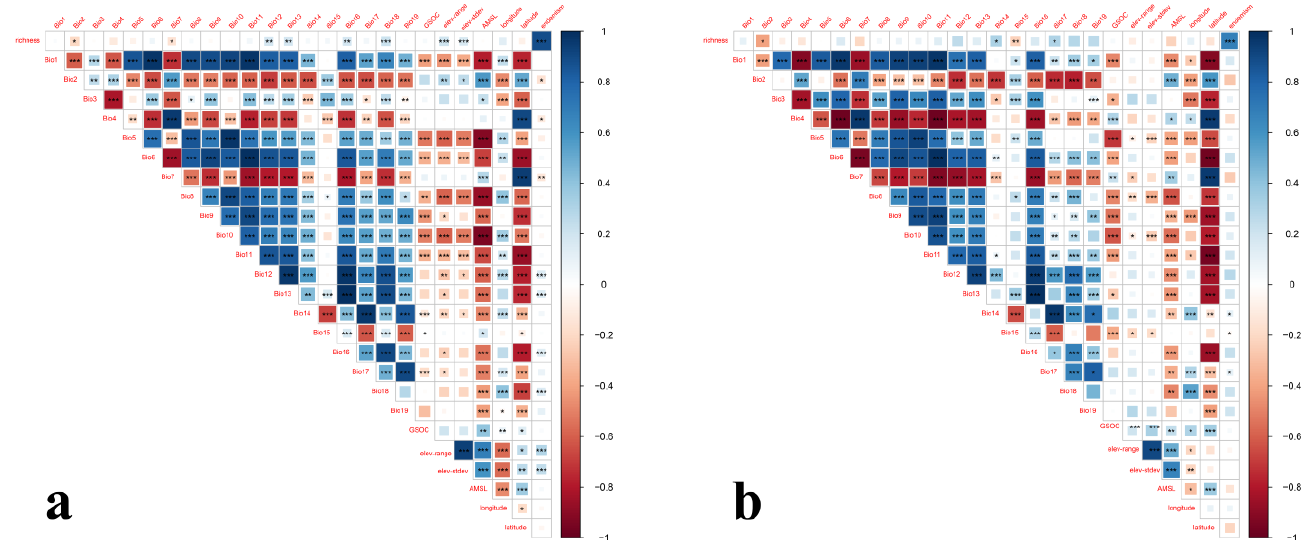
Figure 3. Correlation analysis of environmental factors with Tipulidae richness and endemism in the Qinghai-Tibet Plateau and its surrounding area. ( a ) Mountainous regions; ( b ) Non-mountainous regions. Warm colors represent negative correlation, cool colors represent positive correlation, and the darker the color, the higher the correlation. The significant level of correlation: * p < 0.05, ** p < 0.01, *** p < 0.005.